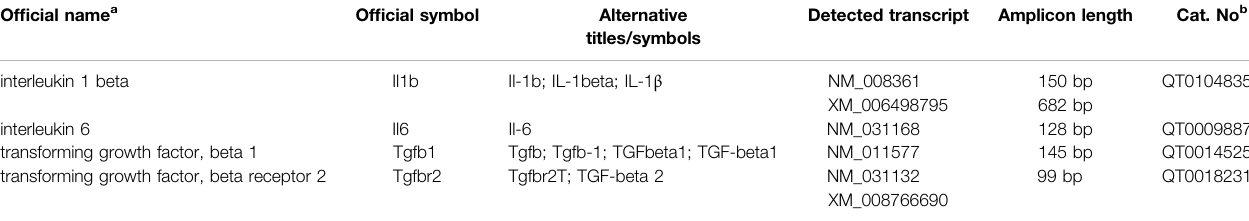
TABLE 1 | The list of primers used for quantitative real-time PCR